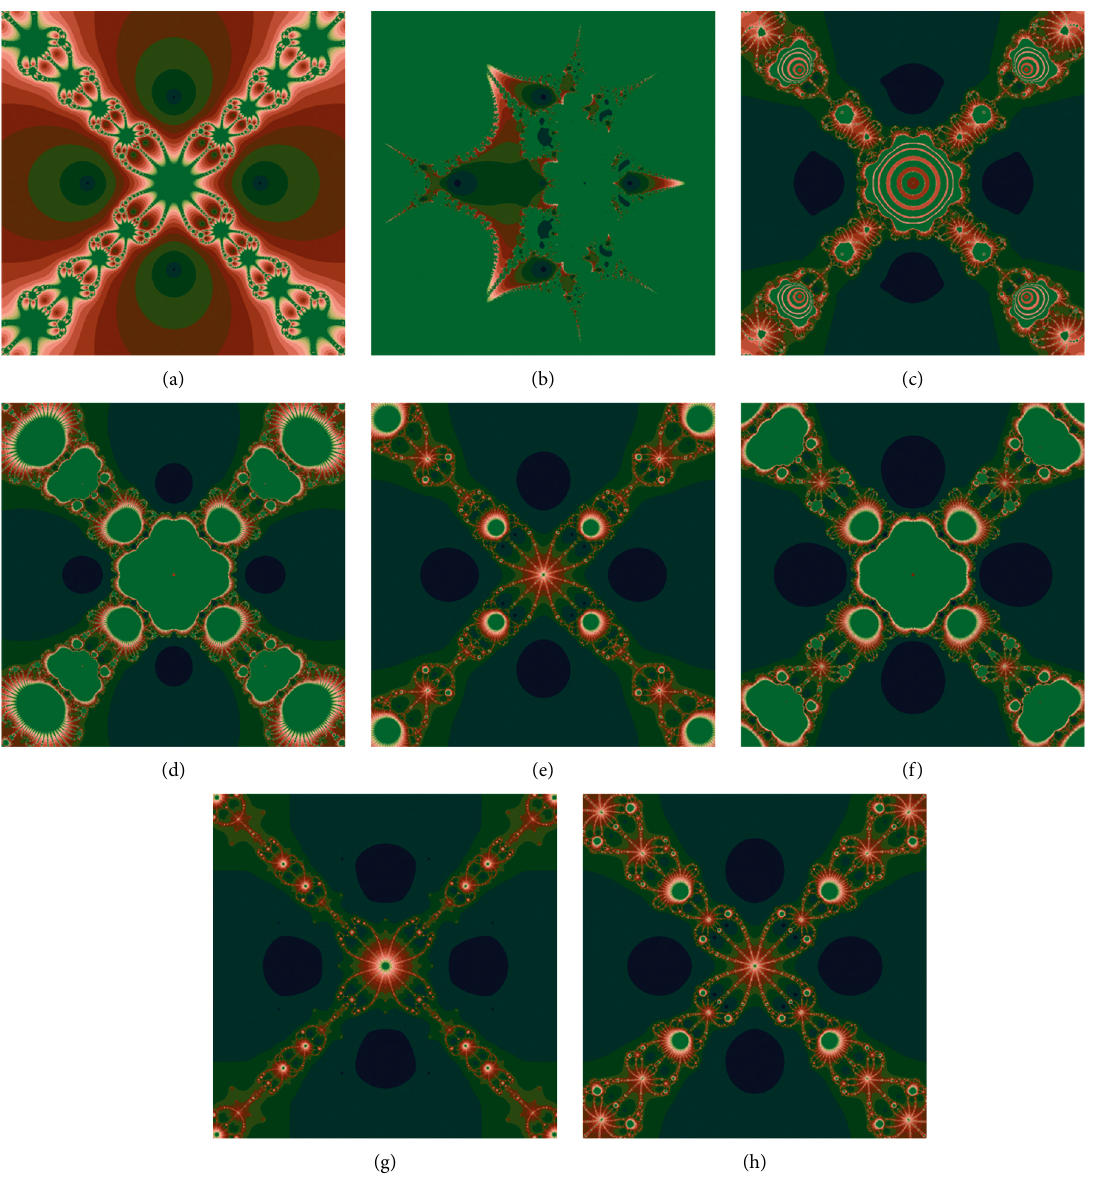
Figure 6: Polynomiograph for q